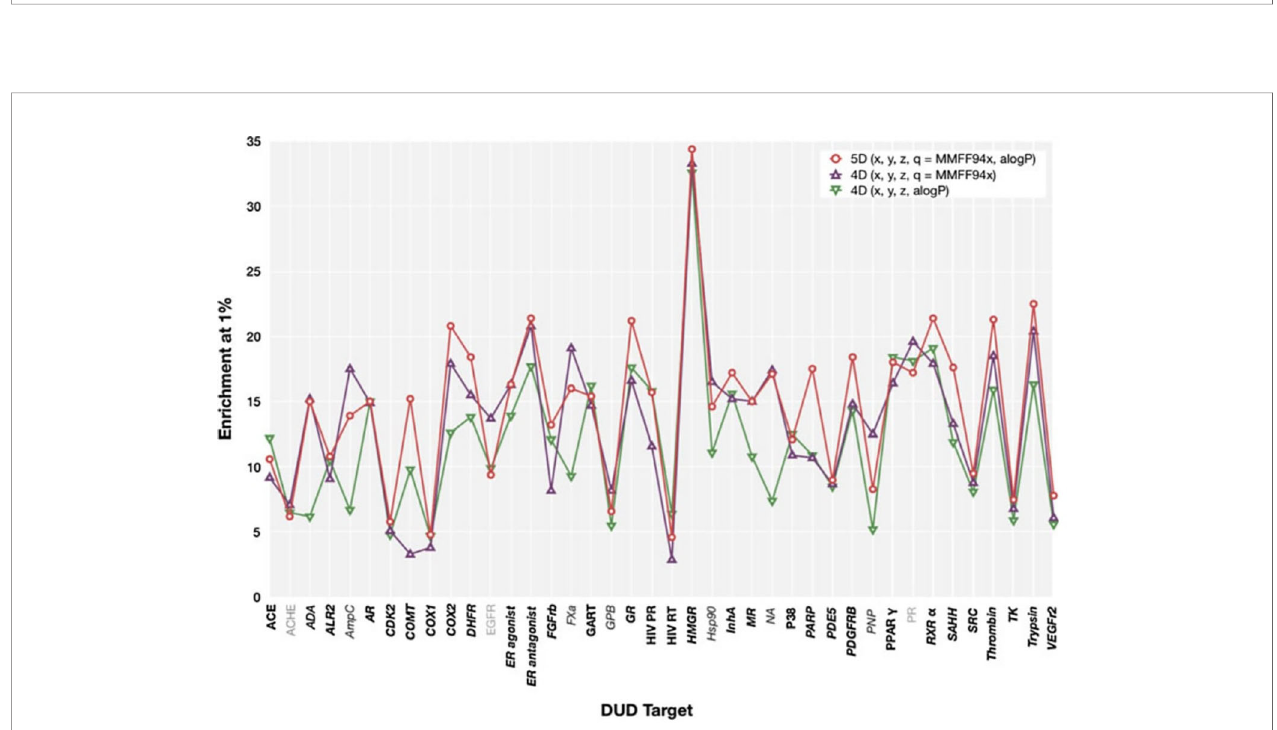
FIGURE 4 | ElectroShape 5D EF 1% calculated on the DUD dataset as reported in Armstrong et al. (2011). Legend: 5D(x,y,z,q = MMFF94x,aLogP) — ElectroShape 5D with partial charge and lipophilicity as the 4th and 5th dimensions, 4D(x,y,z,q = MMFF94x) — ElectroShape 4D using partial charge as the 4th dimension, 4D(x,y,z, q = aLogP) — ElectroShape 4D using lipophilicity as the 4th dimension. Reproduced from Armstrong et al.,